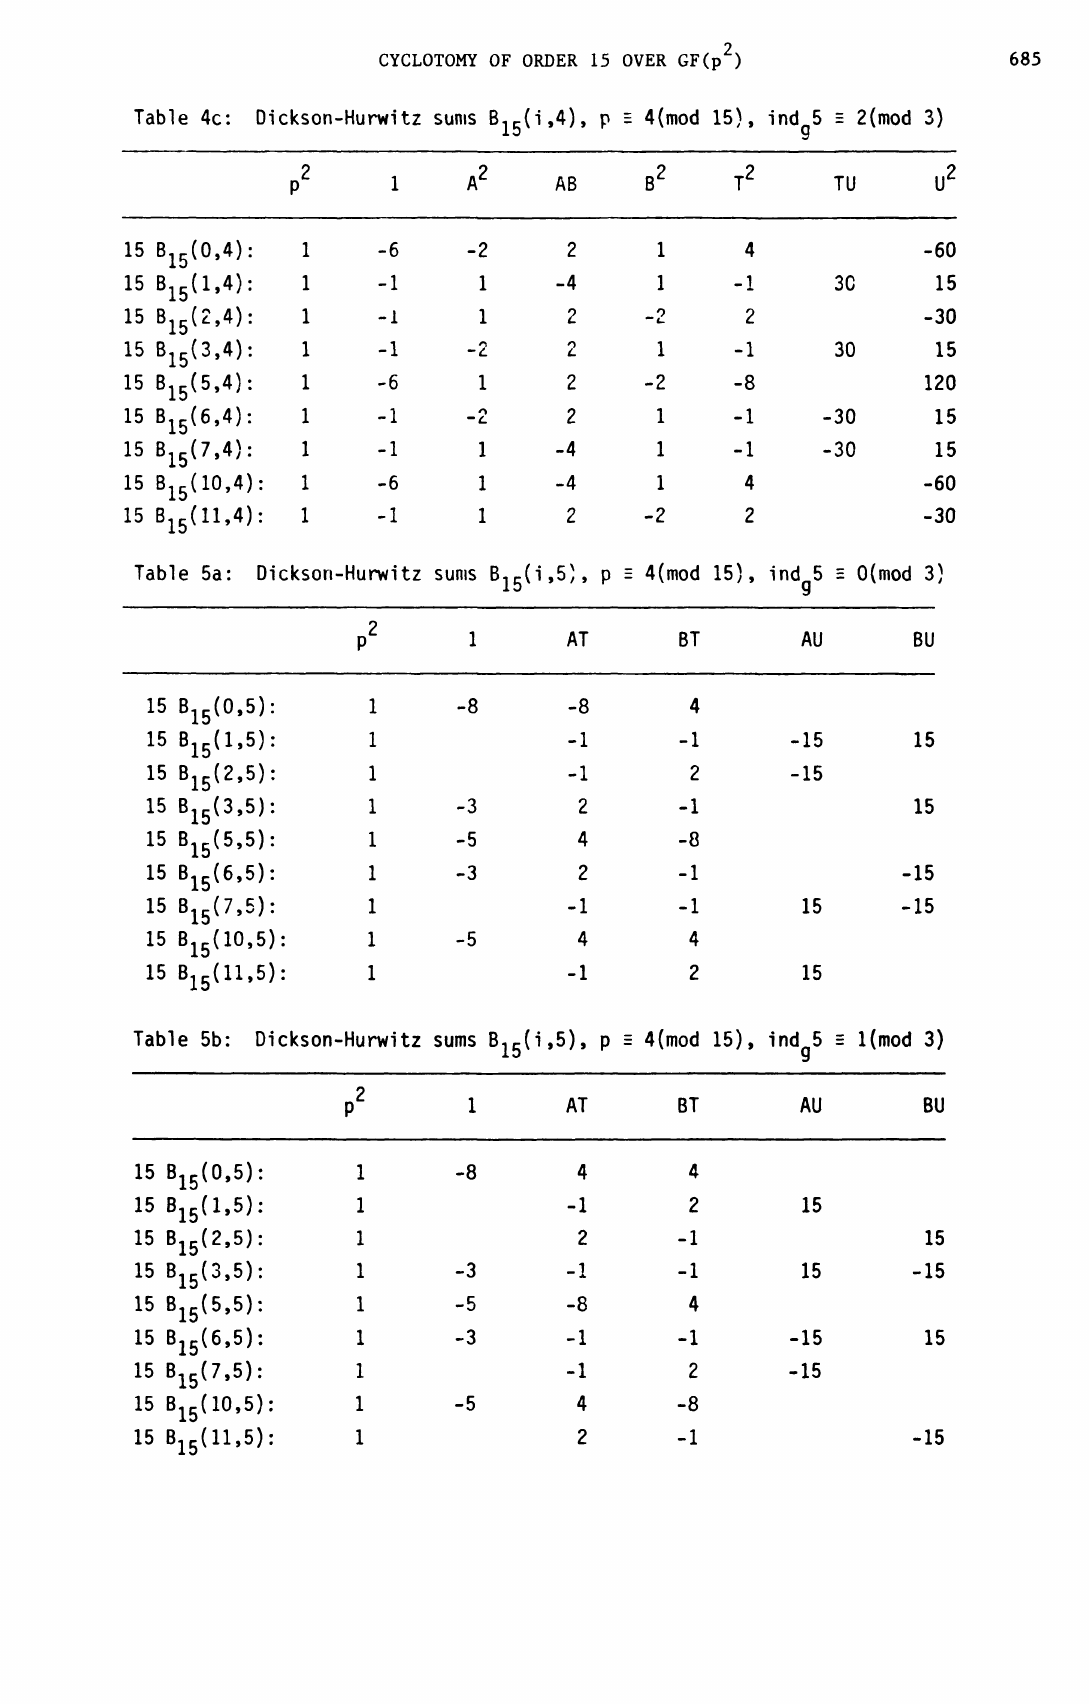
CYCLOTOMY OF ORDER 15 OVER GF(p Dickson-Hurwitz sums B15(i,4), p